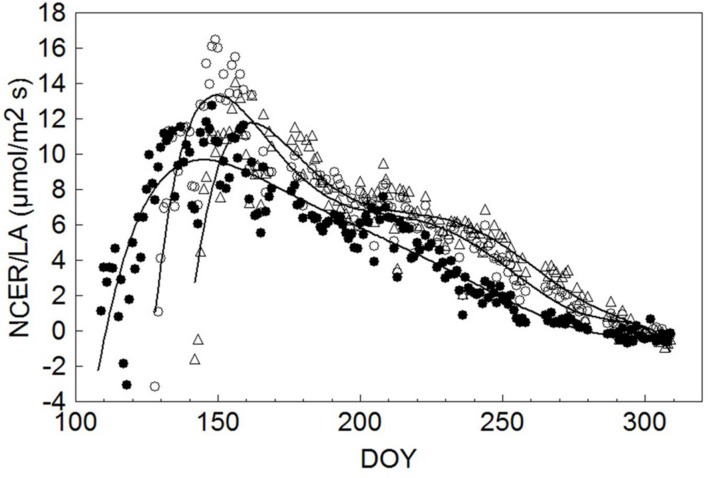
Seasonal trends of daily mean canopy net CO2 exchange rate per unit leaf area (NCER/LA, μmol/m2 s) measured in SWP (●), LWP (∘) and VLWP (△). Each data point is the mean of four vine replicates. For each treatment data were fitted by a six order high precision polynomial curve yielding R2 = 0.85 in SWP, R2 = 0.89 in LWP and R2 = 0.87 in VLWP.